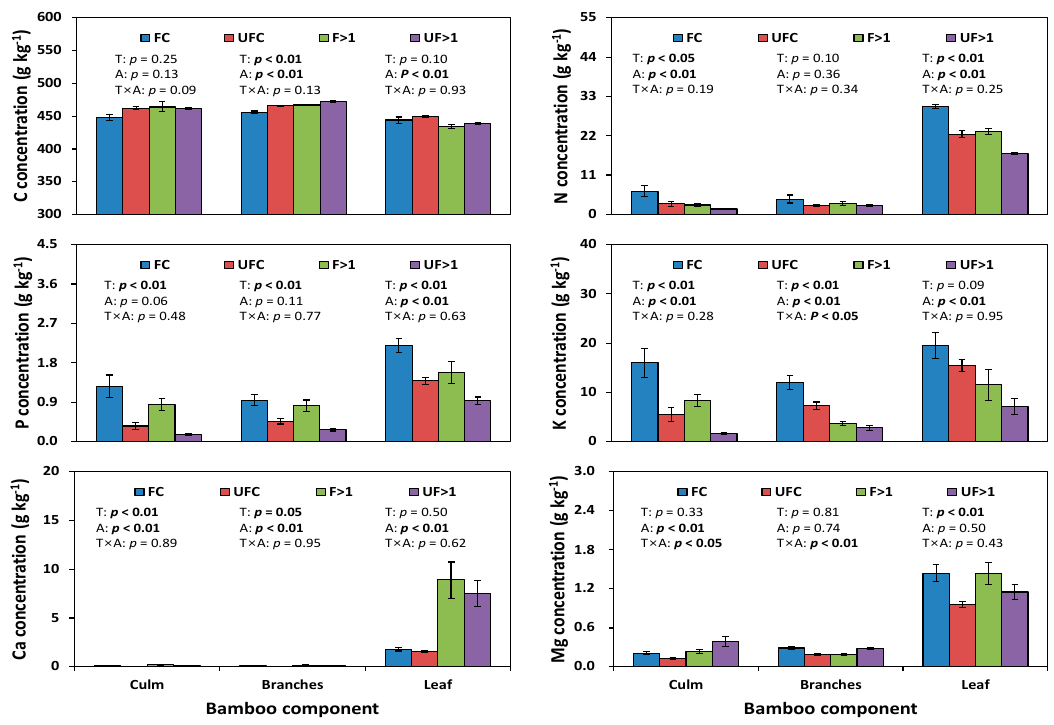
Figure 2. Nutrient concentration ( n = 5) of aboveground bamboo components in a Moso bamboo stand (T: fertilizer treatment; A: bamboo age classes; T × A: interactions; FC: current-year bamboo in fertilized plot; UFC: current-year bamboo in unfertilized plot; F > 1: 1-year-old bamboo in fertilized plot; UF > 1: 1-year-old bamboo in unfertilized plot). Vertical bars represent standard error. Bold values denote significance at p < 0.05.